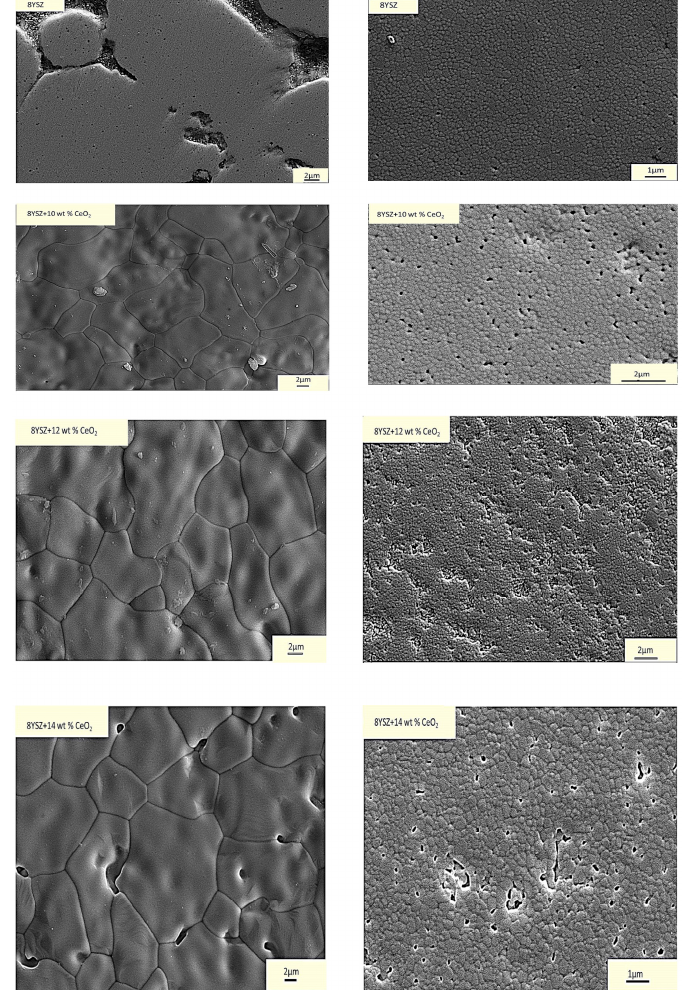
Figure 2. SEM images of CeO 2 doped YSZ sintered ceramics. ( a ) 8 mol % YSZ; ( b ) 10 wt % CeO 2 +8YSZ; ( c ) 12 wt % CeO 2 +8YSZ; and, ( d ) 14 wt % CeO 2 +8YSZ. (Left side conventional and Right side Microwave sintered samples).